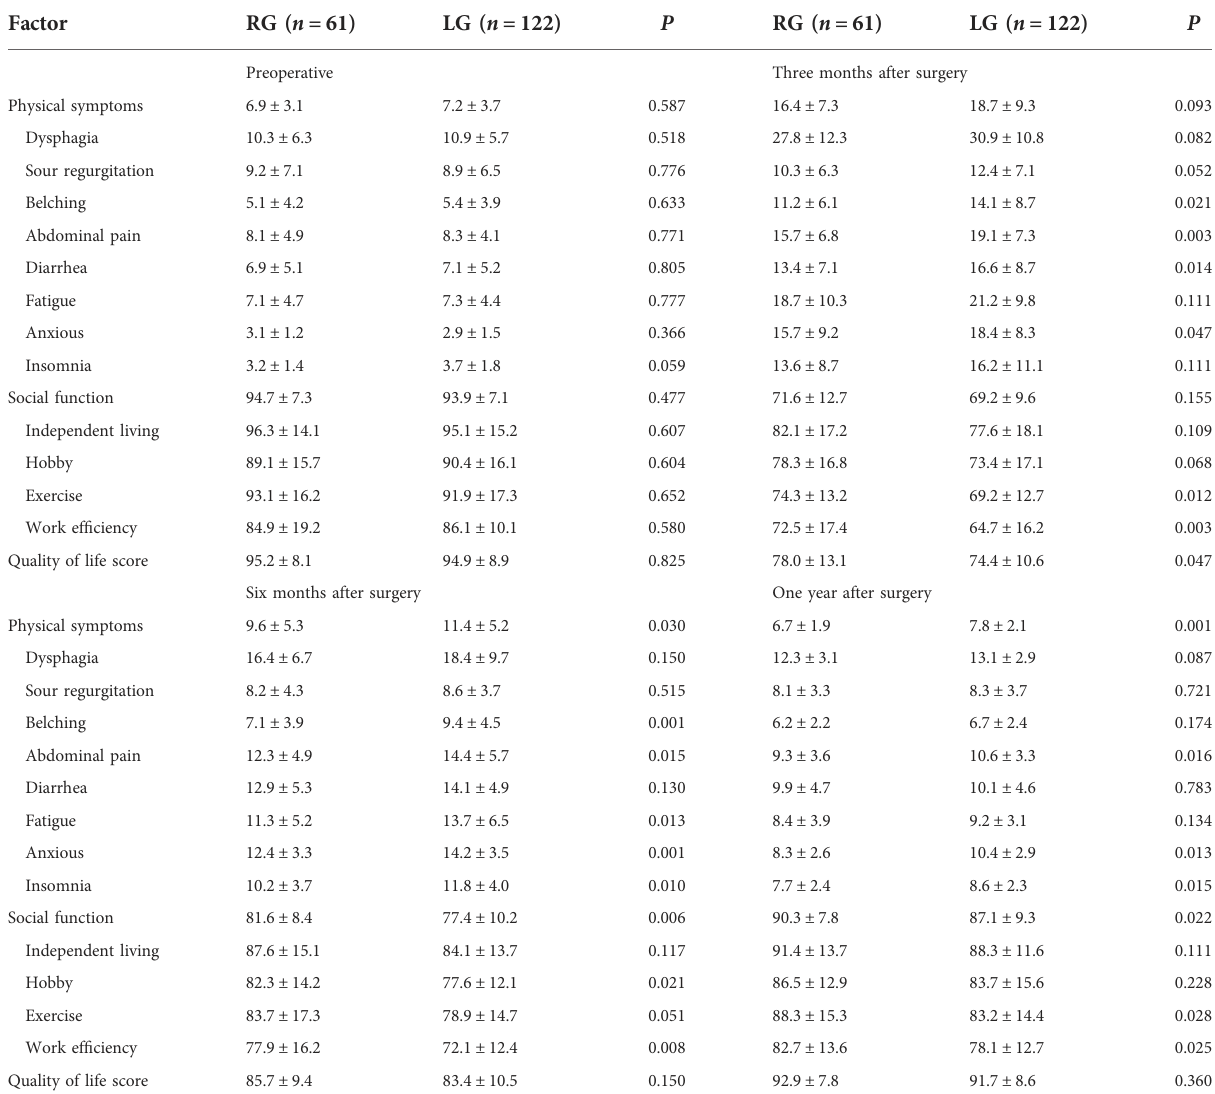
TABLE 5 Assessment of quality of